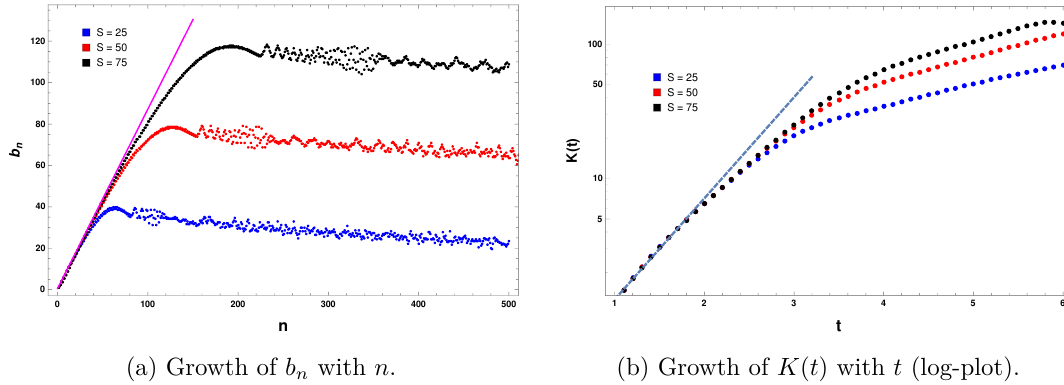
(b) Growth of K ( t ) with t (log-plot). Figure 3. (a) Behavior of Lanczos coefficients b n with n . At small n , the growth of b n is linear and indistinguishable for all spins. After some n the higher spin saturates to a larger value of b before n eventually falling to zero. This is a consequence of the finite size of the system (b) Behavior of K-complexity (log-plot) with time. At early time growth is exponential, as expected from a chaotic system. After a time scale of the order of system size, the growth reduces to a power-law nature, before eventually saturating (at large times). While it is not evident from the figure, it can be seen that the K-complexities for higher spins saturate at higher